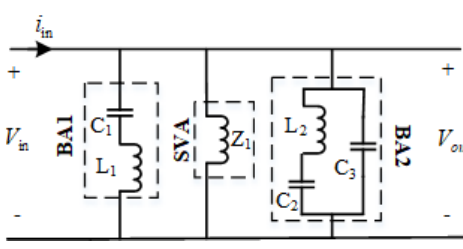
Fig. 6. Structure diagram of tuning